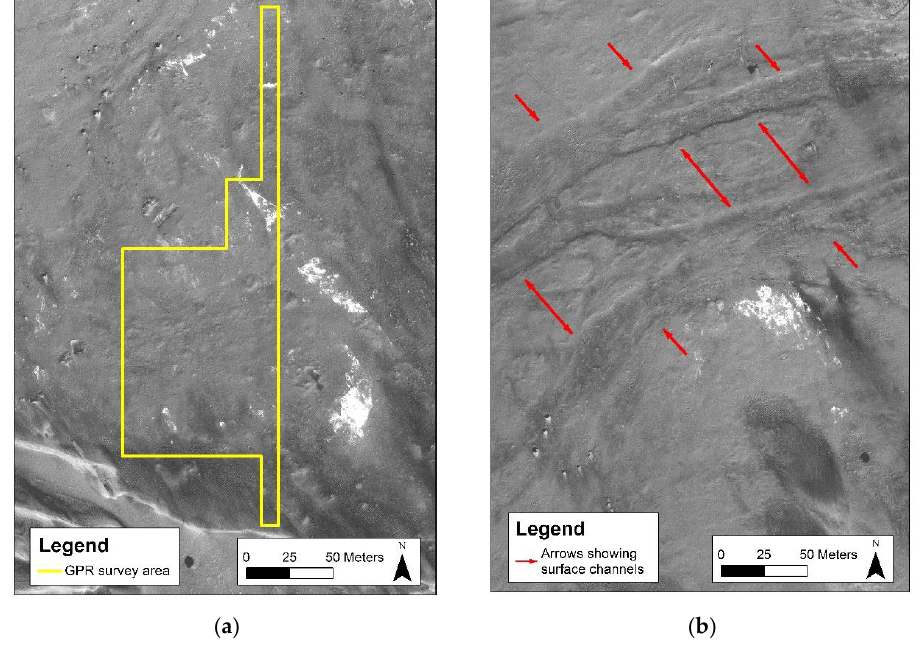
Figure 3 . WorldView 3 panchromatic images. ( a ) No channels are visible within the GPR survey area. ( b ) Surface channels visible ~800 m to the northeast of the survey area.